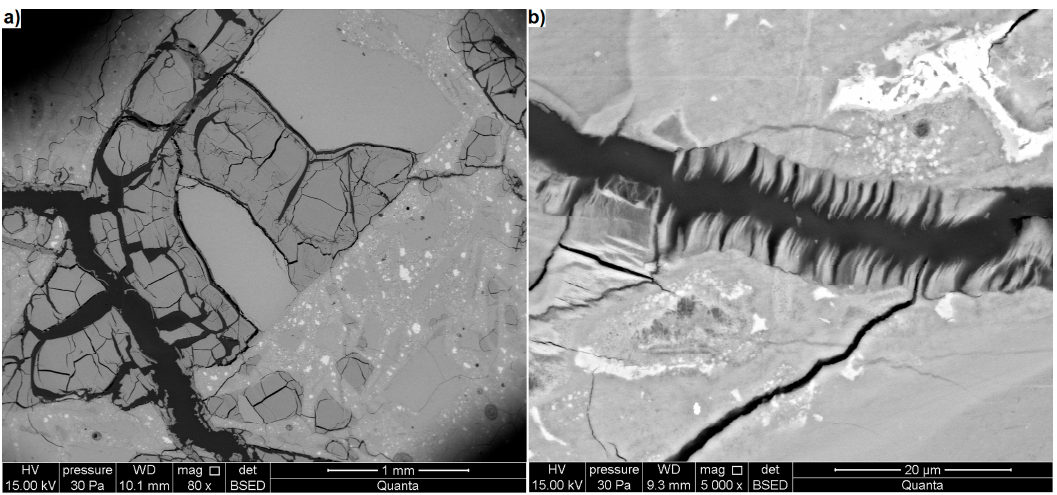
Figure 10. ( a ) large glass particle with a variable degradation level, ( b ) a crack running through the cement paste (BSE).